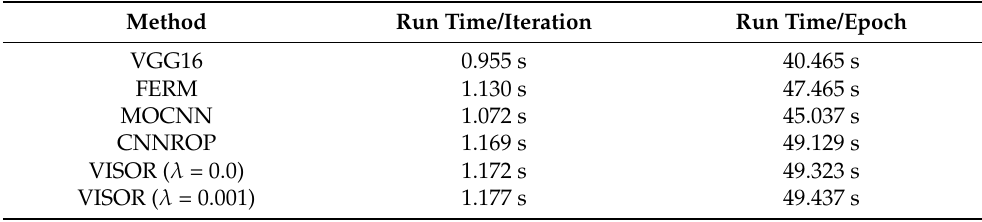
Table 5. The run time per iteration or per epoch for the proposed and baseline algorithms with the ExFRIDA dataset.